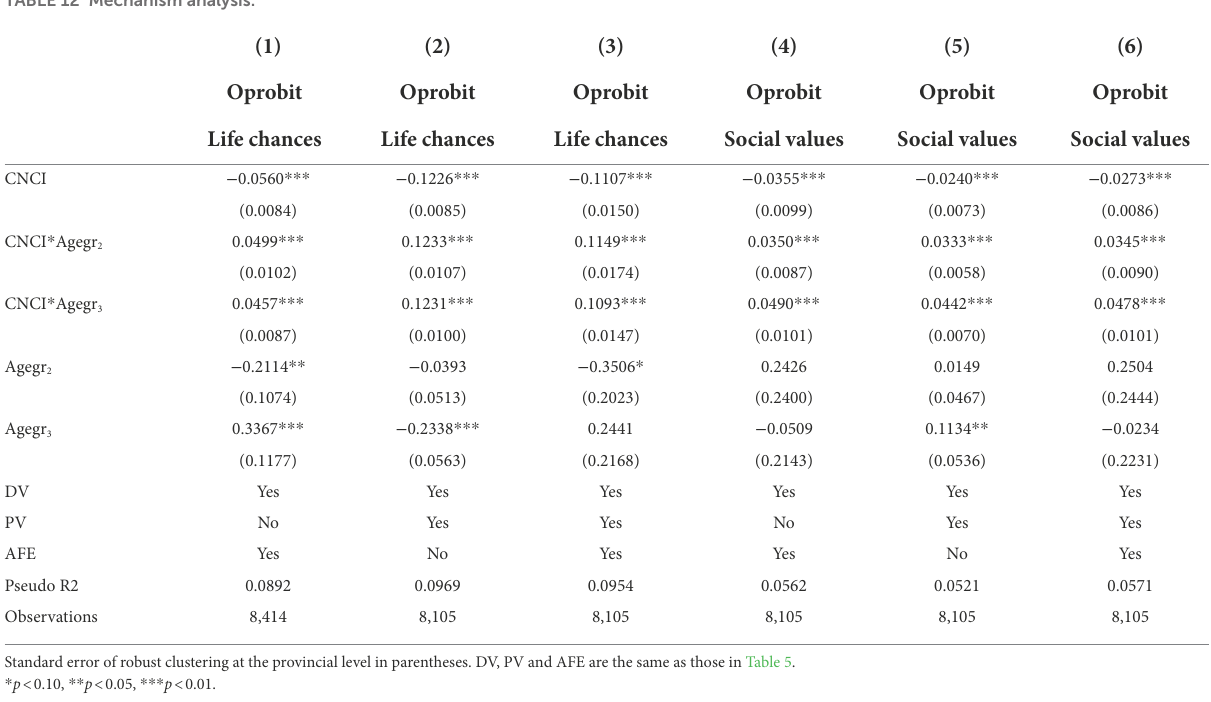
TABLE 12 Mechanism analysis.